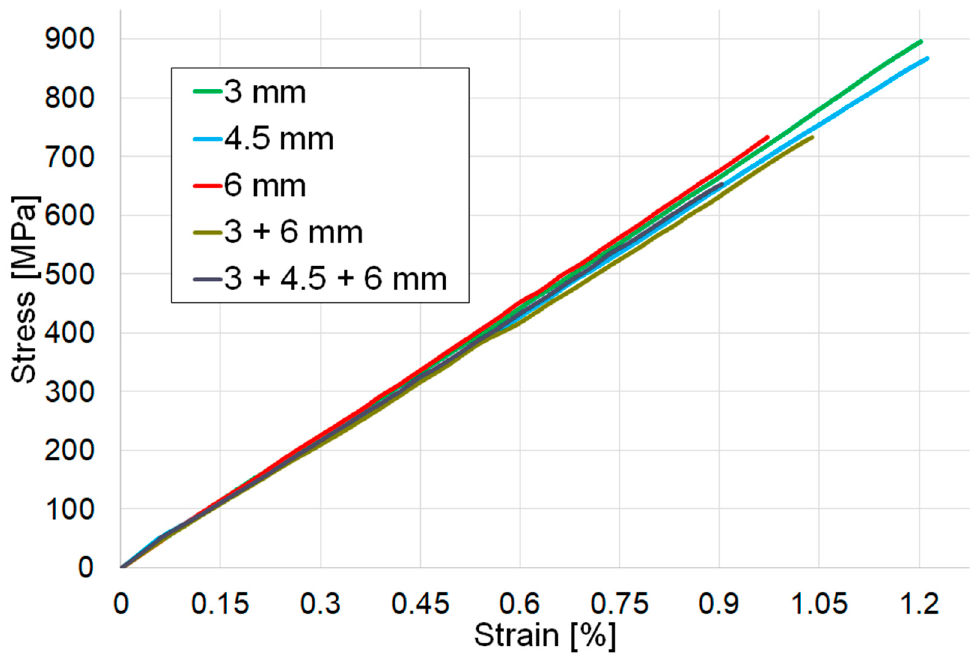
Figure 4. Representative tensile stress-strain curves